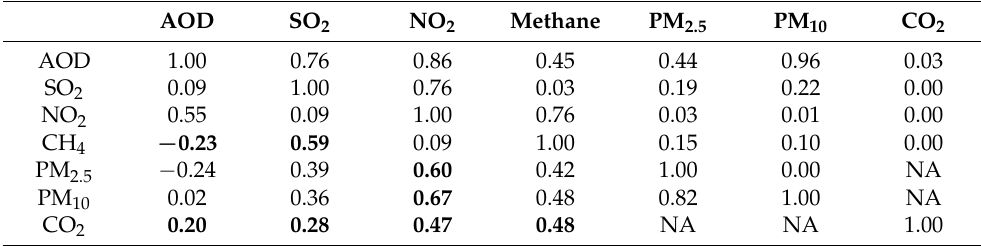
Table 6. Correlation matrix of trace gases. The lower diagonal values are the correlation coefficient, and the upper diagonal are the p -values, signifying the correlation intensity among pollutants. AOD SO 2 NO 2 Methane PM 2.5 PM 10 CO 2 AOD 1.00 0.76 0.86 0.45 0.44 0.96 0.03 SO 2 0.09 1.00 0.76 0.03 0.19 0.22 0.00 NO 2 0.55 0.09 1.00 0.76 0.03 0.01 0.00 CH 4 − 0.23 0.59 0.09 1.00 0.15 0.10 0.00 PM 2.5 − 0.24 0.39 0.60 0.42 1.00 0.00 NA PM 10 0.02 0.36 0.67 0.48 0.82 1.00 NA CO 2 0.20 0.28 0.47 0.48 NA NA 1.00 Bold: Significant correlations at a ≥ 95% significance